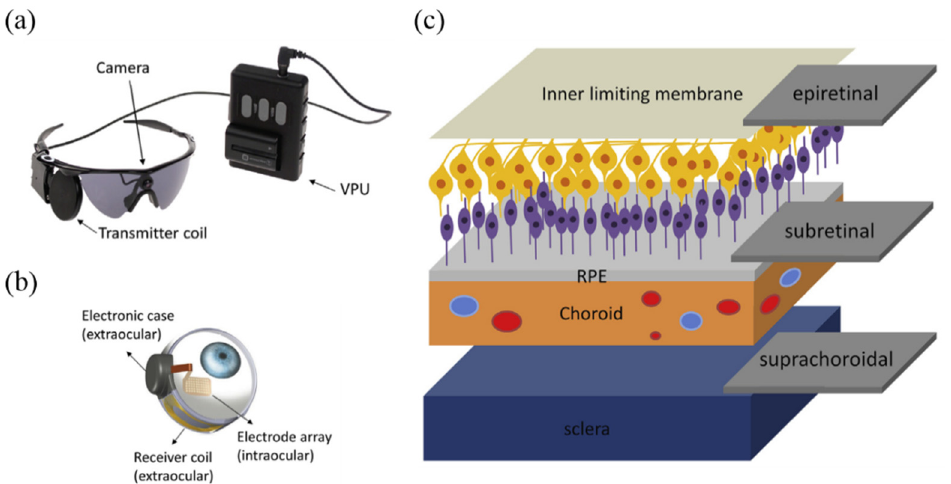
Figure 1. ( a ) External and ( b ) implant part of the Argus II system [7]; ( c ) illustration of the implantation sites of the visual cortex, epiretinal, subretinal, and supra-choroidal prostheses [7]. Reproduced with permission from [7], published by Elsevier, 2016.